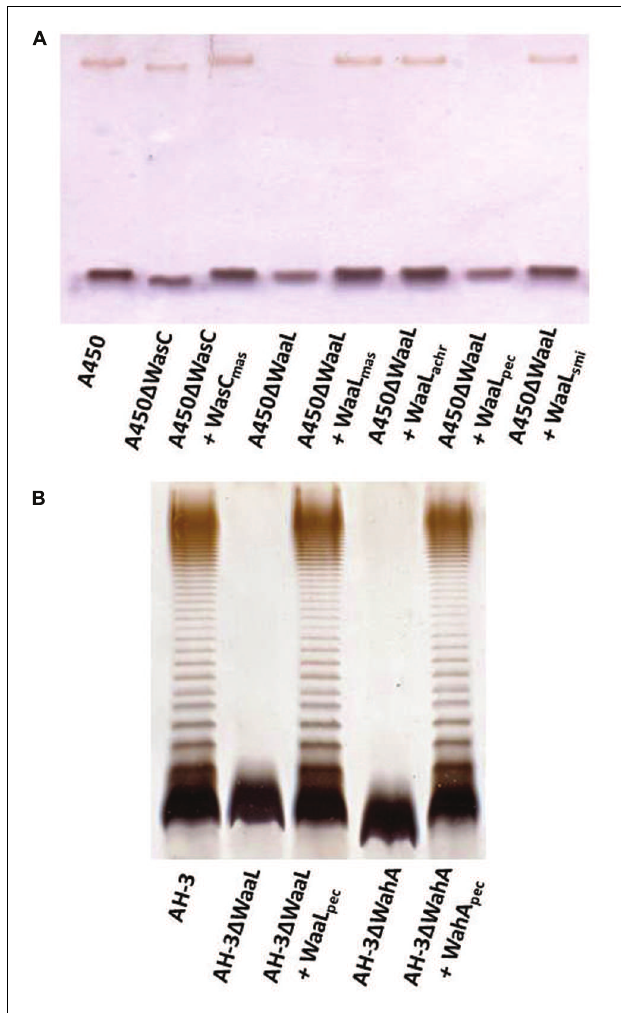
FIGURE 7 | (A) Lipopolysaccharide analyzed by SDS-Tricine gel from A. salmonicida A450 (cid:49) WasC and A450 (cid:49) WaaL mutants and complemented mutant strains with pBAD33 plasmids carrying different single genes. (B) LPS analyzed by SDS-PAGE (12%) from A. hydrophila AH-3 (cid:49) WaaL and AH-3 (cid:49) WahA mutants and complemented mutant strains with pBAD33 plasmids carrying different single genes.